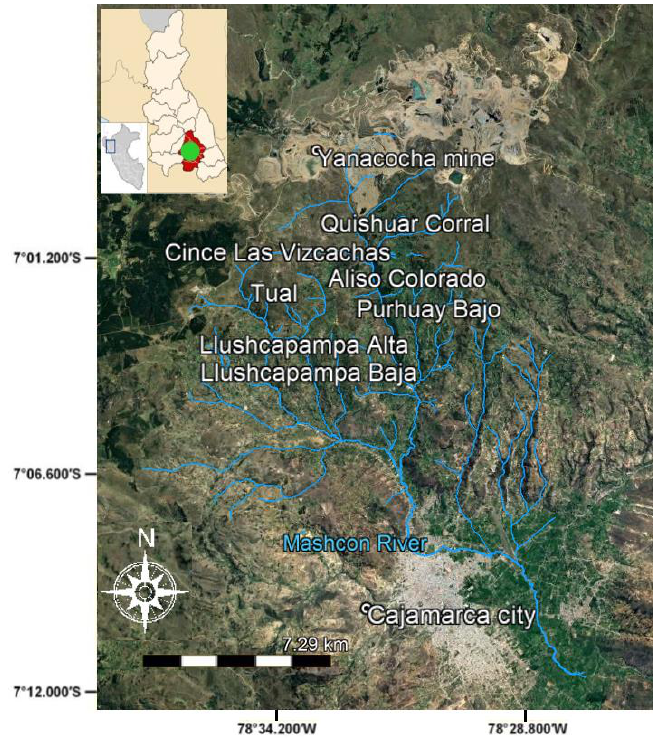
Figure 1. The Mashcon watershed and the locations relevant to this study. Adapted from [25].